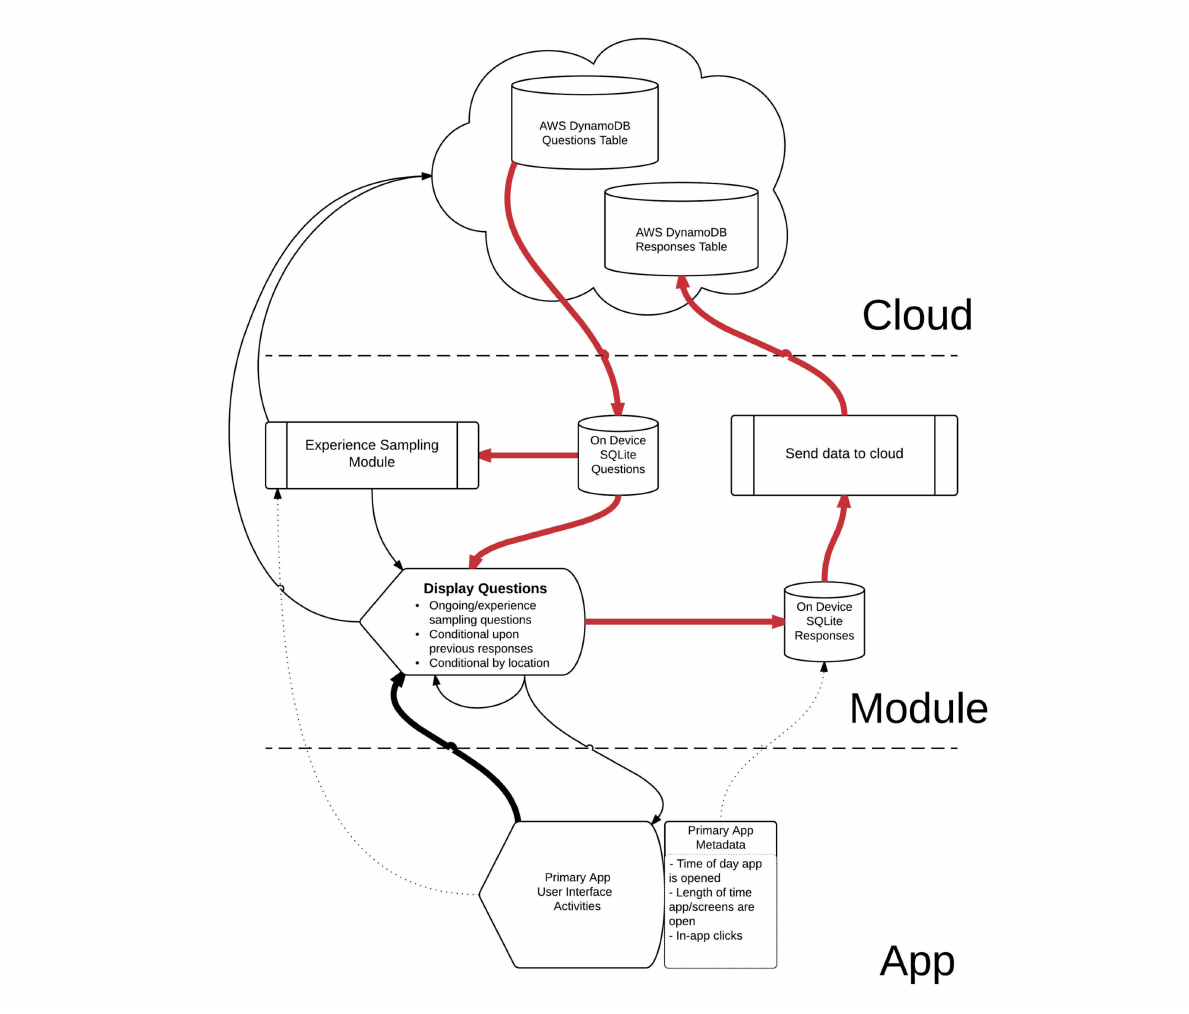
Figure 1. Overview of the Survalytics platform architecture. Black arrows are calls between subclasses of the module. Red arrows demonstrate data flow. Dotted lines serve to clarify the functionality and data storage existing in the original app, in the Survalytics module, and in the cloud database. The software module may be called by the primary app in several different ways. For surveys, the app should send a call to display survey questions. The app may make a different call to store arbitrary analytic data in the cloud. Finally, if desired, the app can call the experience sampling submodule. AWS: Amazon Web